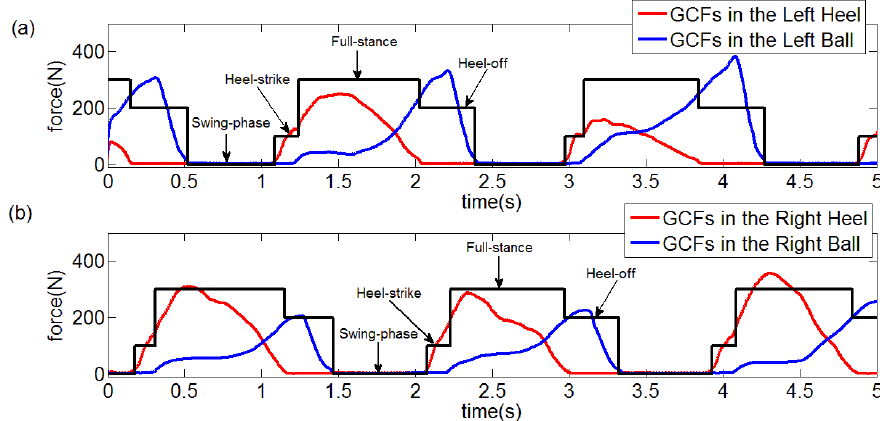
Figure 13. ( a ) Results of gait pattern detection for left foot, ( b ) Results of gait pattern detection for right foot.